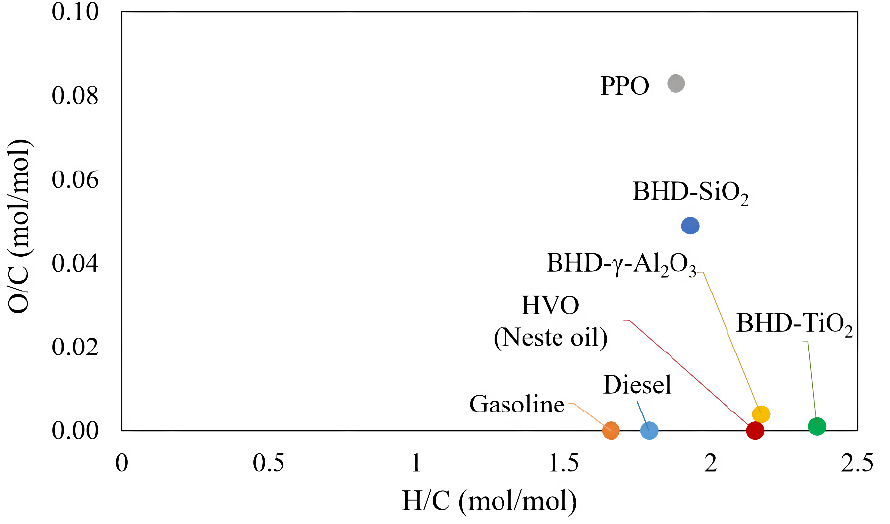
Figure 9. Comparison of H/C and O/C ratio for the hydrotreated liquid product over sulfide NiMo/ γ -Al 2 O 3 (BHD-Al 2 O 3 ), NiMo/SiO 2 (BHD-SiO 2 ), and NiMo/TiO 2 (BHD-TiO 2 ) catalysts and Pongamia pinnata oil (PPO) with petroleum fuel and hydrotreated vegetable oil (HVO) from Neste